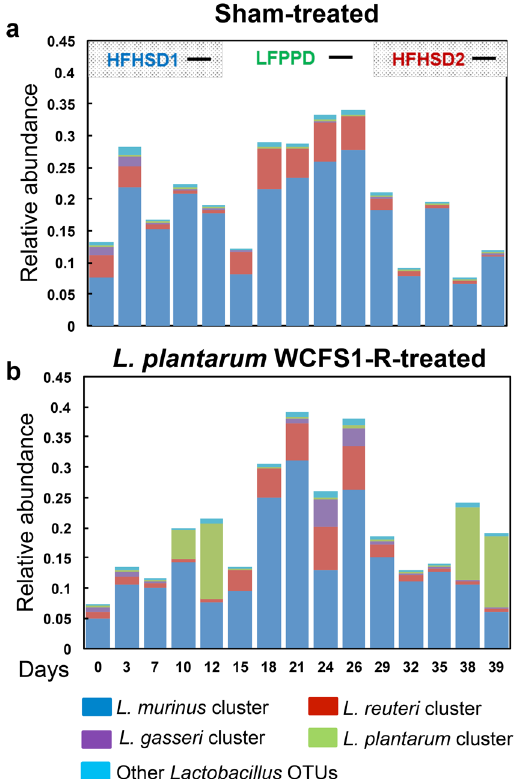
Figure 4. Proportions of intestinal Lactobacillus species changed over time during diet switches. Panel ( a ) and ( b ) correspond to the results from sham-treated and L . plantarum WCFS1-R fed mice respectively. OTUs sharing 100% sequence similarity with its nearest neighbors are shown. Average values of all 8 mice in each group were plotted. Black dashes indicate the days when the mice received L . plantarum